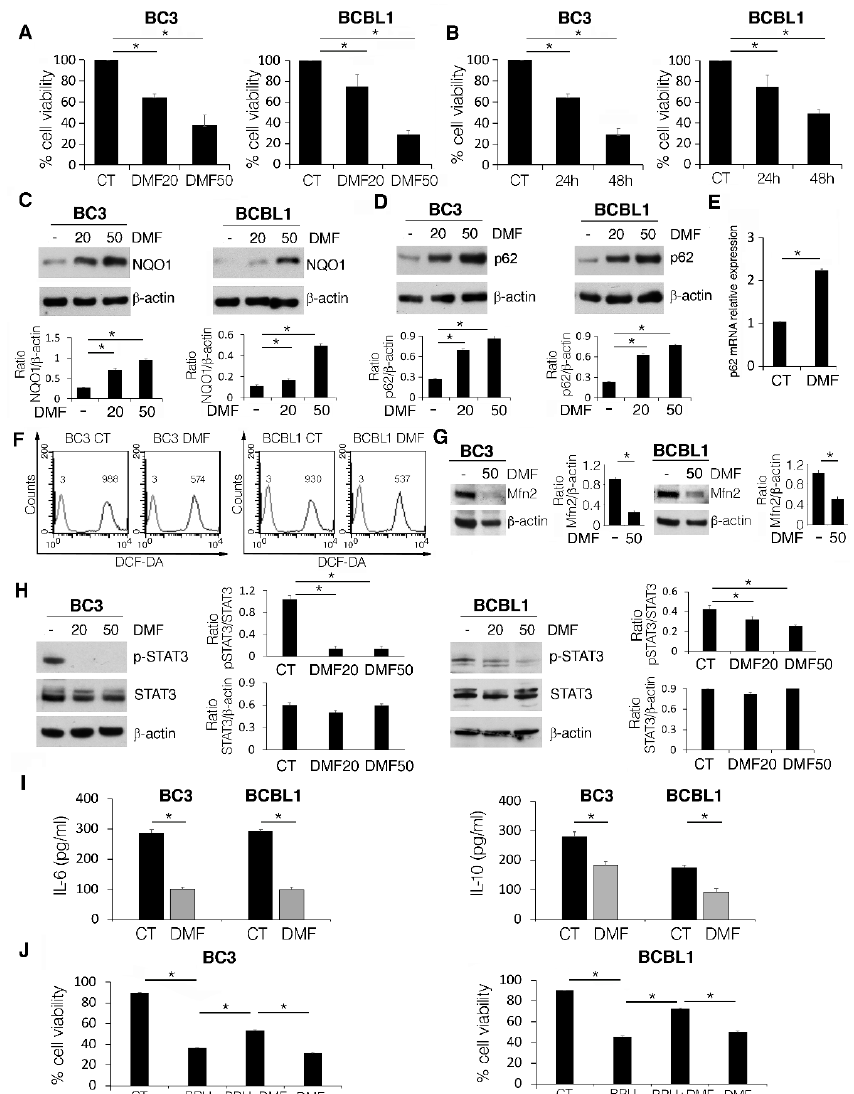
Figure 1. DMF cytotoxicity in PEL cell lines is mediated by NRF2 activation and reduction of intracellular ROS and IL-6 and IL-10 release. ( A , B ) Percentage of cell viability of BC3 and BCBL1 cells, treated or not (CT) with 20 and 50 µ M DMF for 24 h, or with 20 µ M for 24 and 48 h, as evaluated by Trypan blue exclusion assay. ( C ) NQO1 and ( D ) p62/SQSTM (p62) expression levels in BC3 and BCBL1 cells, treated or not (CT) with 20 and 50 µ M DMF for 24 h, assessed by western blotting. β -actin was used as loading control, and one representative experiment out of three is shown. The histograms represent the mean plus SD of the densitometric analysis of the NQO1/ β -actin and p62/ β -actin ratios of three different experiments. ( E ) p62 mRNA level of BC3 cells, treated or not (CT) with 50 µ M DMF for 24 h, was quantitated by qRT-PCR. ( F ) FACS analysis using DC-FDA staining to measure the intracellular ROS in BC3 and BCBL1 cells, treated or not (CT) with 50 µ M DMF for 24 h. ( G ) Western blotting showing MFN2 or ( H ) STAT3 phosphorylation (pSTAT3) in BC3 and BCBL1 cells, treated or not (CT) with 20 and 50 µ M DMF for 24 h. β -actin was used as loading control, and one representative experiment out of three is shown. The histograms represent the mean plus SD of the densitometric analysis of the pSTAT3/STAT3 and STAT3/ β -actin ratios of three different experiments. ( I ) IL-6 and IL-10 release by BC3 and BCBL1 cells, treated or not (CT) with 50 µ M DMF for 24 h. ( J ) Percentage of cell viability of BC3 and BCBL1 cells, co-treated with 20 µ M DMF and 5 nM Brusatol (BRU) for 24 h, evaluated by Trypan blue exclusion assay. In the figure, mean ± standard deviation (SD) of three independent experiments is shown. * p <